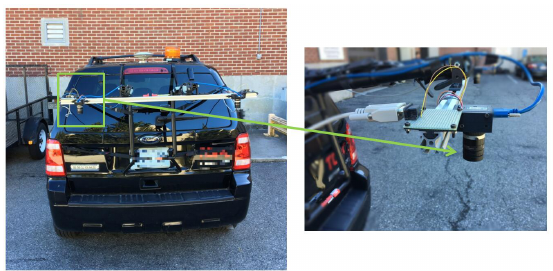
Figure 16. FPGA controlled road surface capturing system with adaptive camera frame rate.